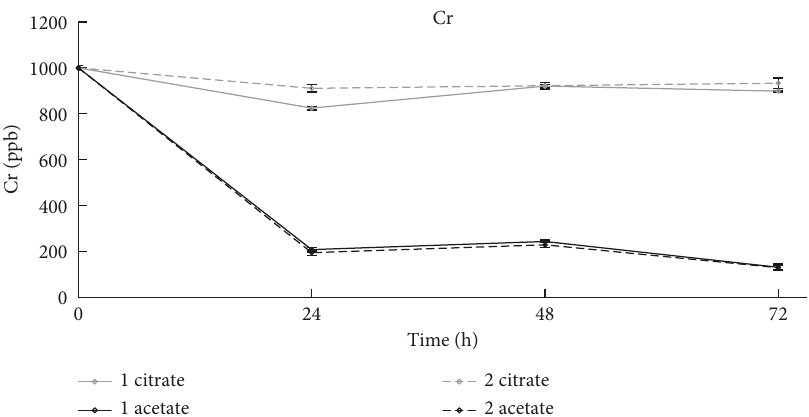
Figure 5: Cr concentration as a function of time in citrate buffer (5 · 10 − 3 M) and acetate buffer (5 · 10 − 3 M) for Colonies 1 and 2. Conditions: 5% sucrose, initial pH � 4.5, and 1:10 Water Kefir/metal solution ratio. n � 3.